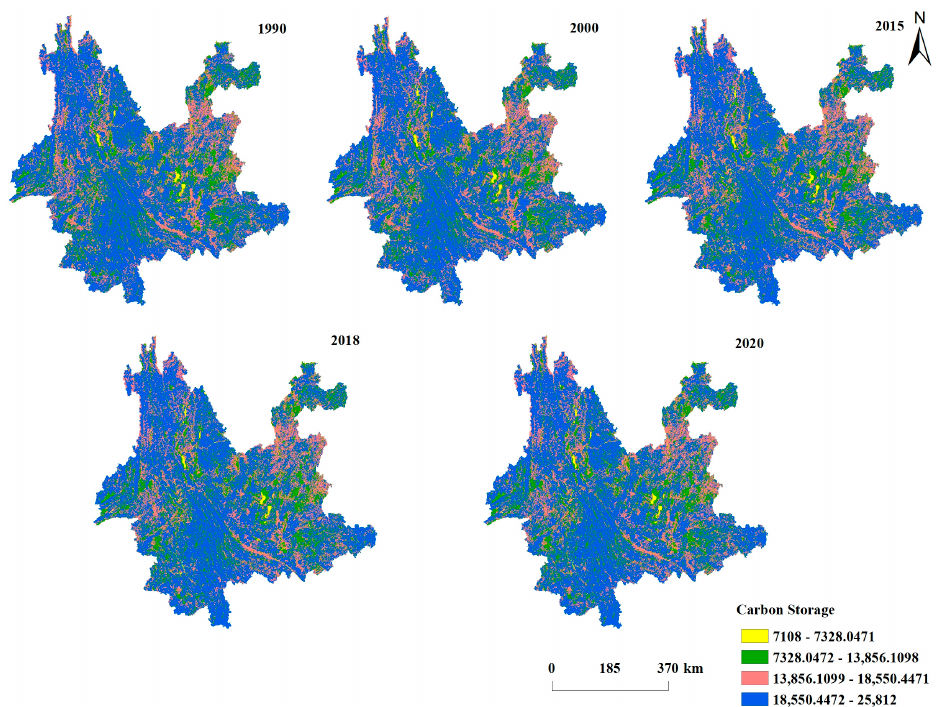
Figure 3. Spatial and temporal distribution of ecosystem carbon stocks in Yunnan Province from 1990 to 2020.